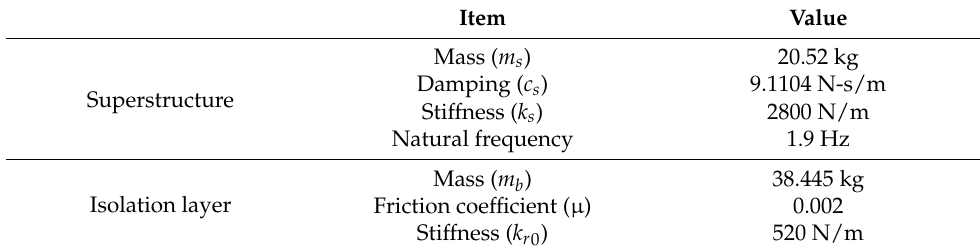
Figure 5. Time history inputs for experimental testing. Table 9. Identified parameters of the superstructure and isolation